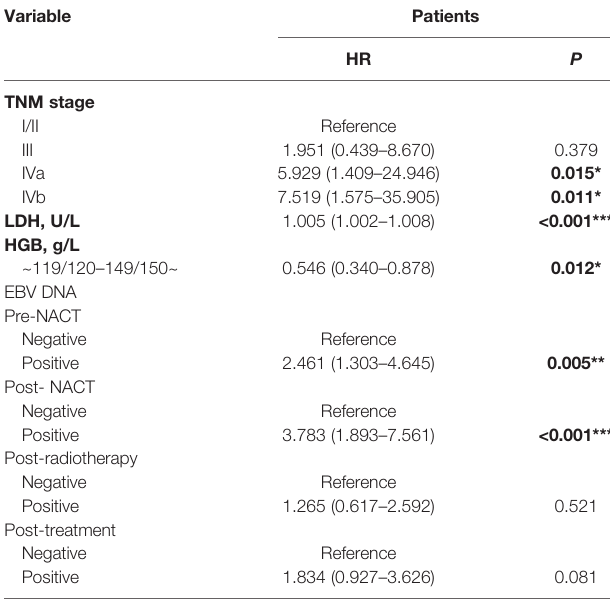
TABLE 2 | Univariate analysis for the progression-free survival of the primary cohort (N = 206). Variable